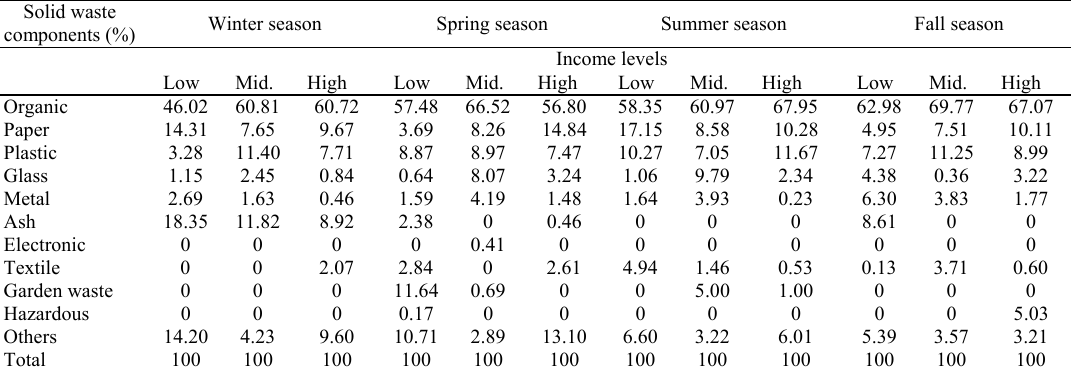
Table 2: Level of income of the neighborhoods in the field of study and seasonal percentages of waste components Solid waste components